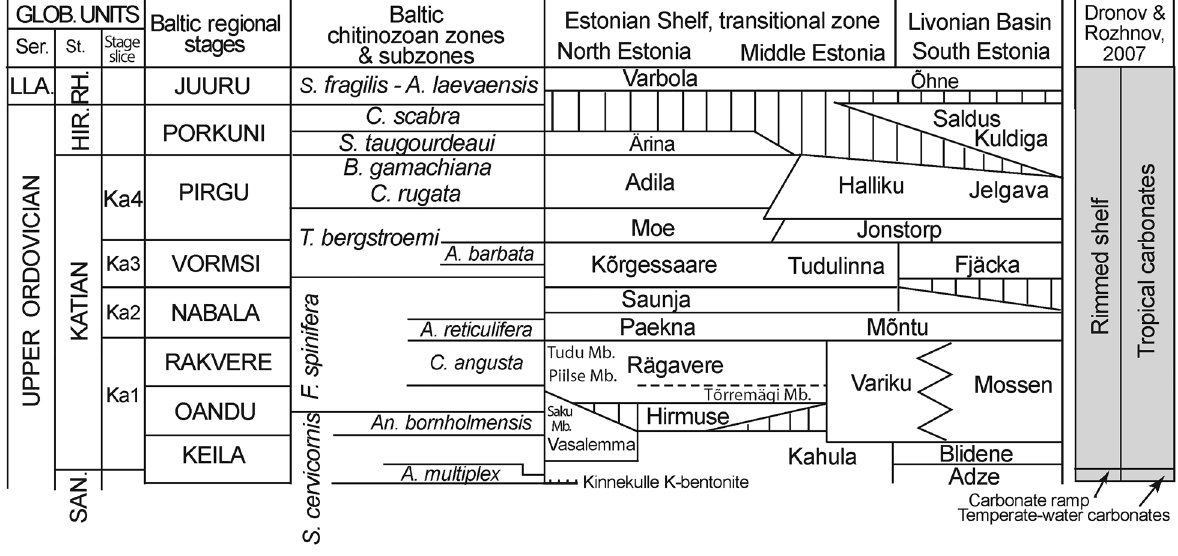
Fig. 2. Stratigraphical classification of the studied rock succession. Modified based on Meidla et al. (2014), Nõlvak et al. (2007) (chitinozoan zonation), Vandenbroucke et al. (2013), Kröger et al. (2016). Abbreviations: Global units: Ser. – series; St. – stage; LLA. – Llandovery; RH. – Rhuddanian; HIR. – Hirnantian; SAN. – Sandbian. The unit names in the areas of the shelf are formations with a few members (Mb.). Full taxonomic names are shown in the text, as well as a remark about the Koigi